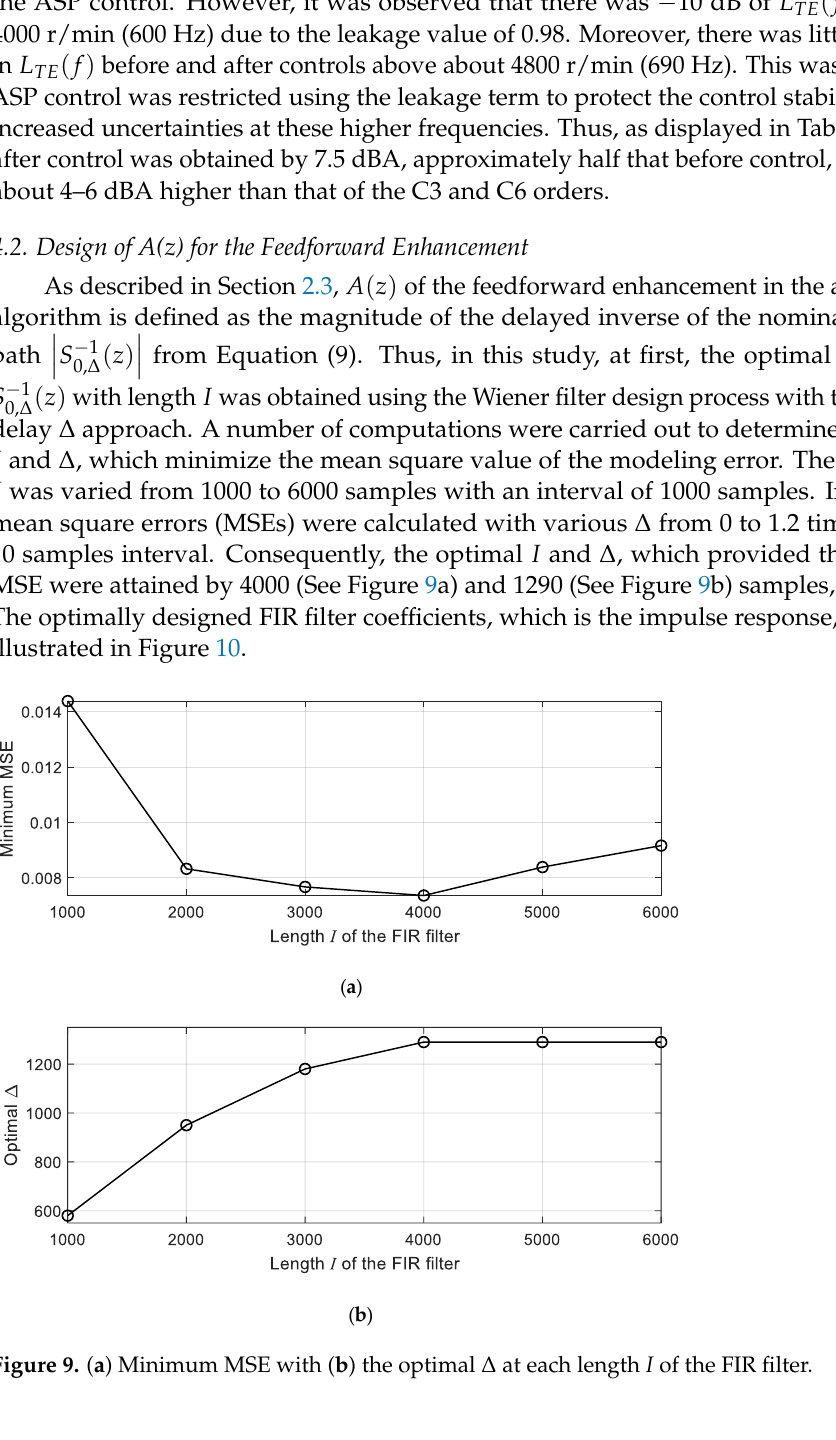
Figure 8. Comparisons of the measured SPL of each order before and after the pure ASP control, and the tracking errors between the measured SPLs and the target profiles. ( a ) SPL of the C3 order. ( b ) Tracking error of the C3 order. ( c ) SPL of the C6 order. ( d ) Tracking error of the C6 order. ( e ) SPL of the C9 order. ( f ) Tracking error of the C9 order.